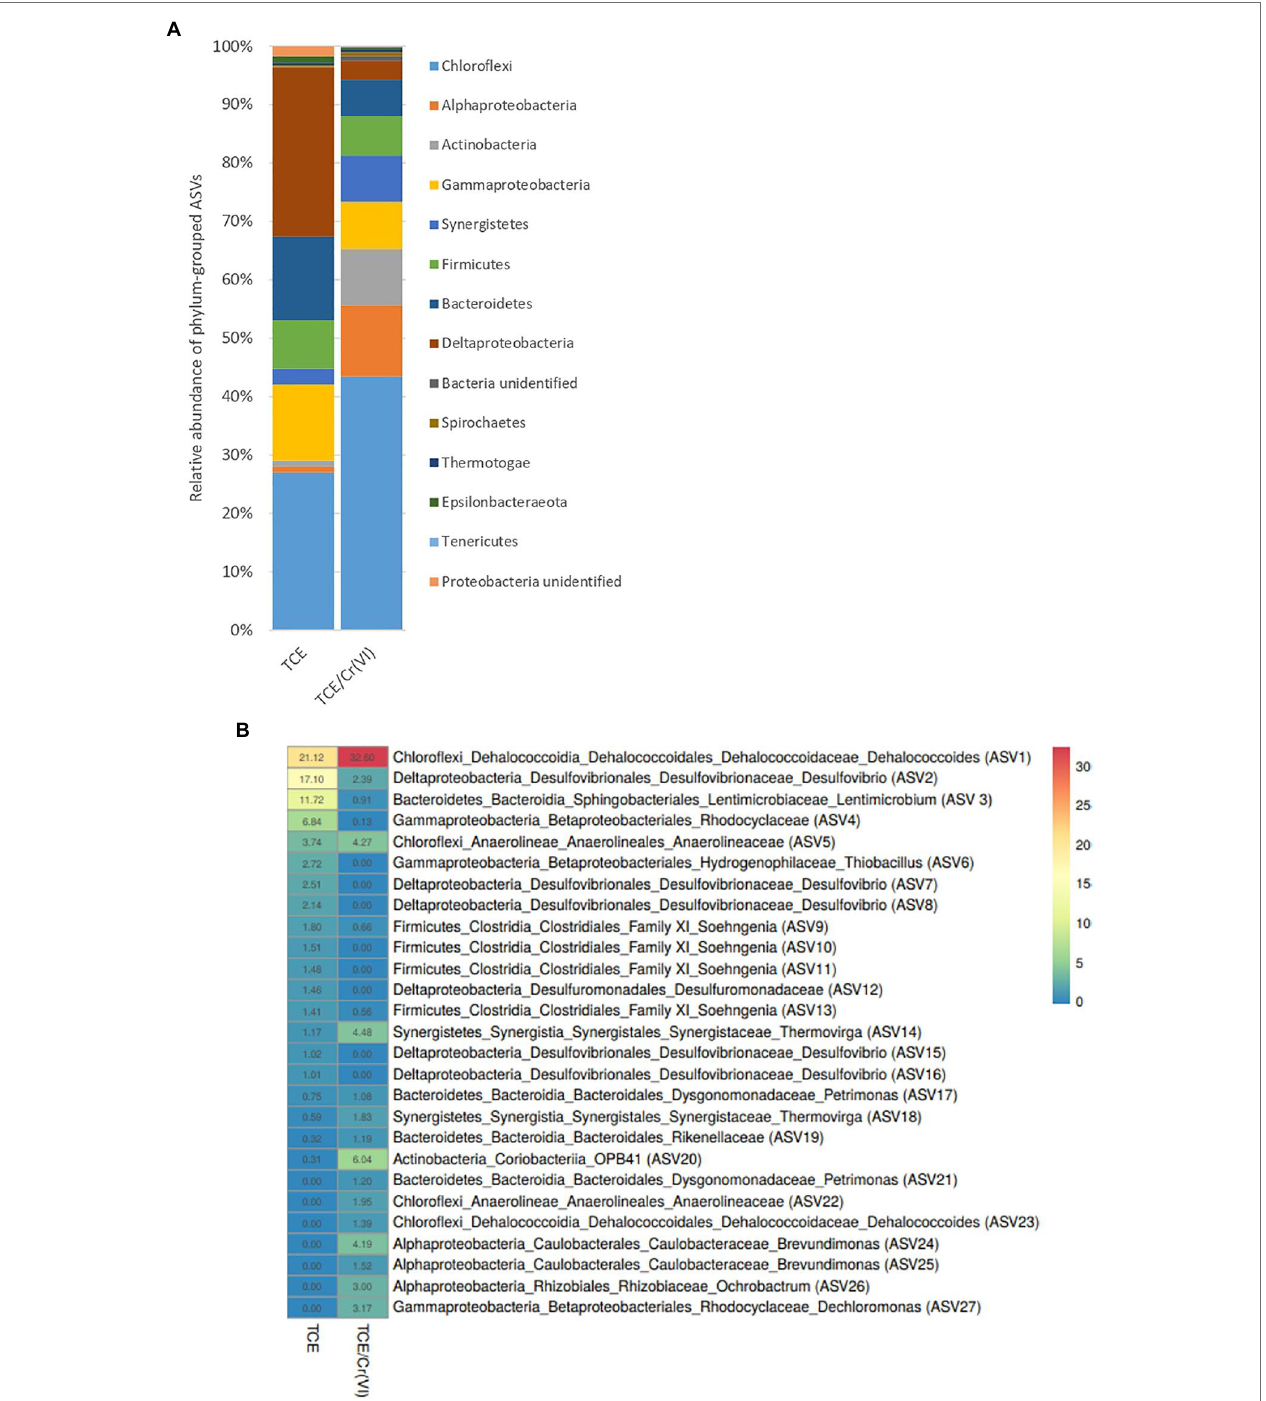
FIGURE 3 | Microbiome composition of the cathodic biofilm at phylum level (A) and heatmap of the most abundant ASVs at genus level (B) found in the biofilm of the bioelectrochemical reactor treating TCE and